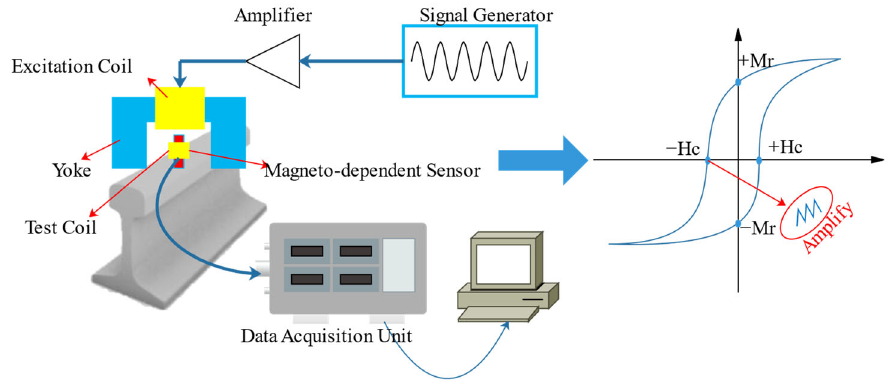
Figure 6. MBN inspection for rail.